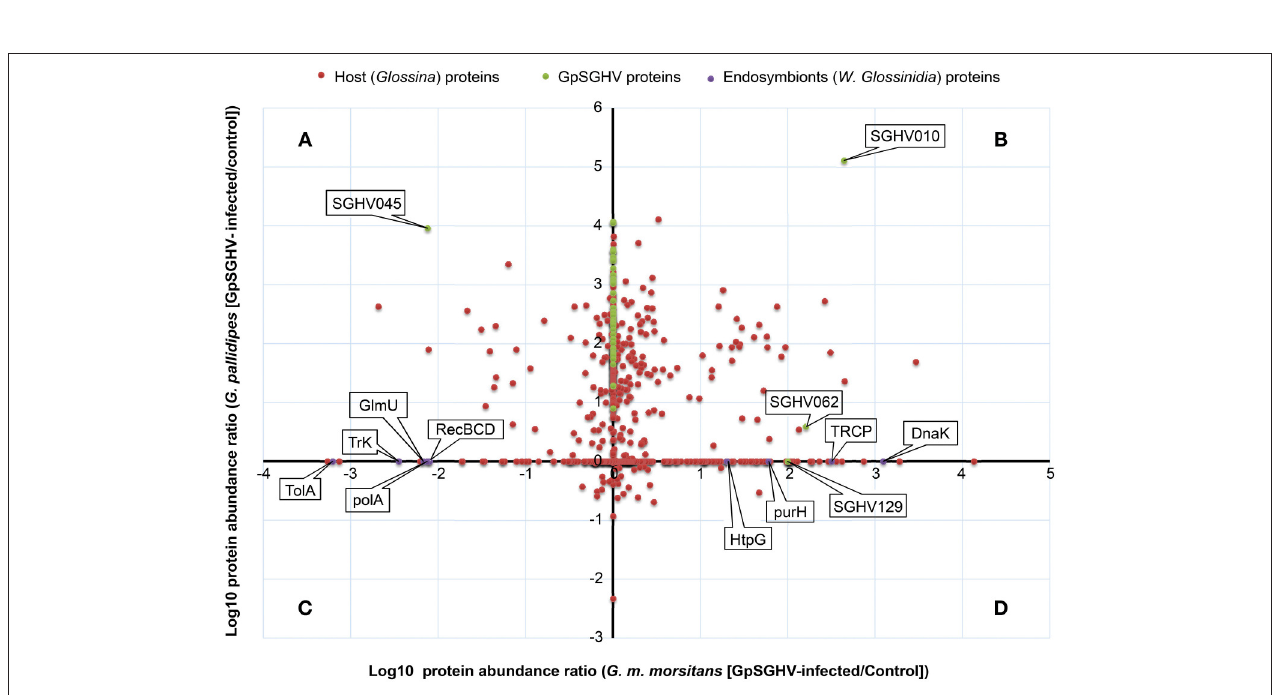
FIGURE 4 | Abundance distribution ratios of GpSGHV-infected G. m. morsitans and G. pallidipes SG proteins. The figure shows a log-log PLOT of the host, viral and endosymbiont proteins (shown in red, green and purple, respectively). (A) Proteins down-regulated in G. m. morsitans but up-regulated in G. pallidipes . (B) Proteins up-regulated in both G. m. morsitans and G. pallidipes . (C) Proteins down-regulated in G. pallidipes but up-regulated in G. m. morsitans . (D) Proteins down-regulated in both G. m. morsitans and G. pallidipes . Proteins aligned along the Y-axis were detectable in G. pallidipes but were not detectable in G. m. morsitans , while the proteins aligned along the X-axis were detectable in G. m. morsitans but not detectable in G. pallidipes.